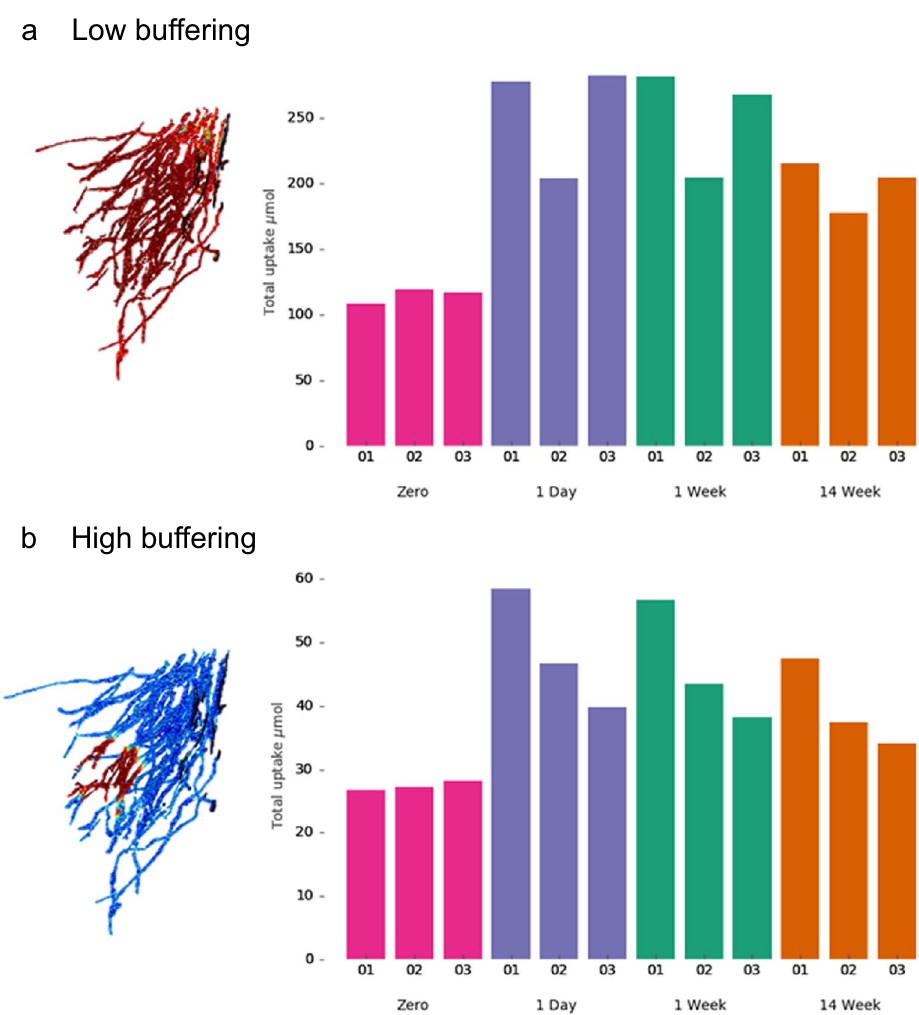
Figure 6. Simulated total P uptake integrated over the whole experiment in ( a ) low buffering soil ( b ) high buffering soil. Different cases represent P dissolving from a pellet over 1-day, 1-week, and 14-weeks, and a case with no added P fertiliser (zero fertiliser) for three different root systems (samples 01, 02, 03). For visualisation purposes, root images show uptake rate at 43